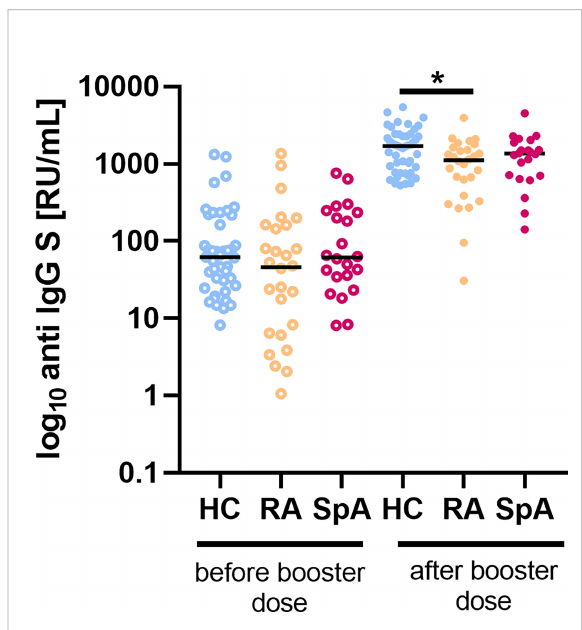
FIGURE 1 The level of IgG anti-S before and after a booster dose of the COVID-19 vaccine in patients with rheumatoid arthritis (RA; n=28) and spondyloarthritis (SpA; n=21) compared to healthy controls (HC; n=43/47 before/after). In the group comparison, the Kruskal – Wallis test with post hoc analysis with the Dunn ’ s test was performed. Dots represent individual values and the line represents the median. A p values were expressed as follows: 0.05>p>0.01 as*.